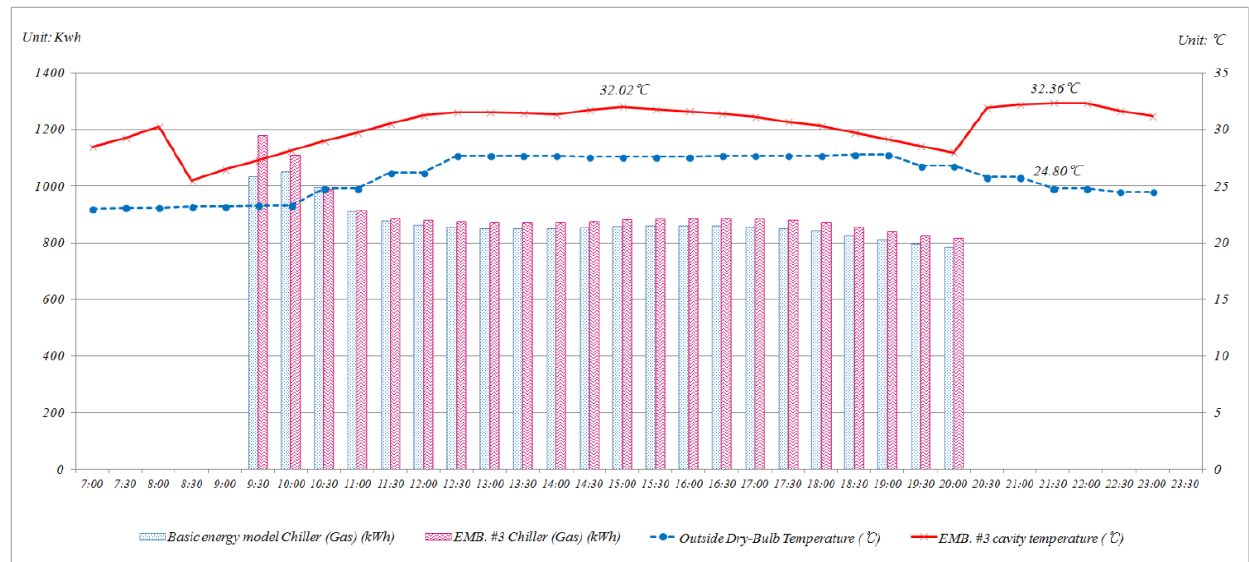
Figure 8. Temperature-time profile and cooling energy consumption on a summer day (basic energy model vs. EM B